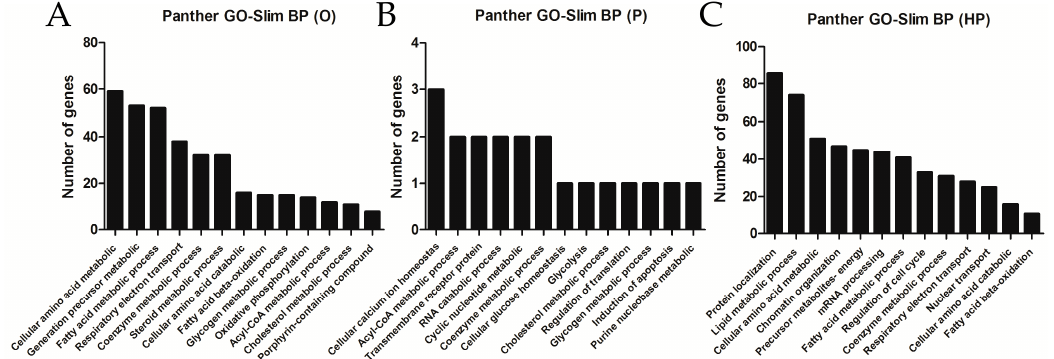
Figure 7. Functional enrichment analysis of differentially expressed genes. Panther Gene Ontology (GO) biological processes (BP) of over-represented terms of liver transcriptome according to the lipid supplementation: ( A ): O, olive oil group; ( B ): P, palm oil group; ( C ): HP, hybrid palm oil group.